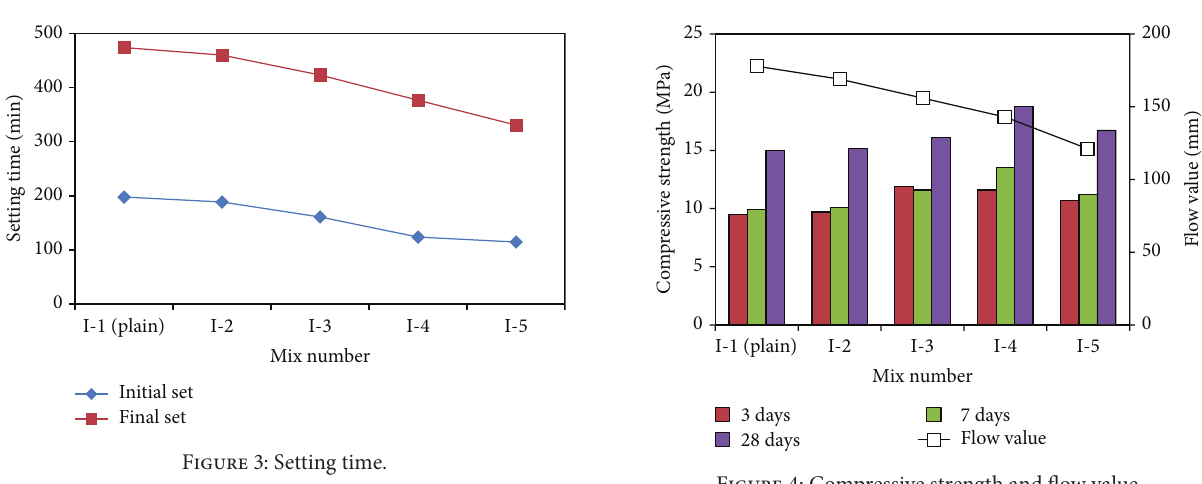
Figure 4: Compressive strength and flow